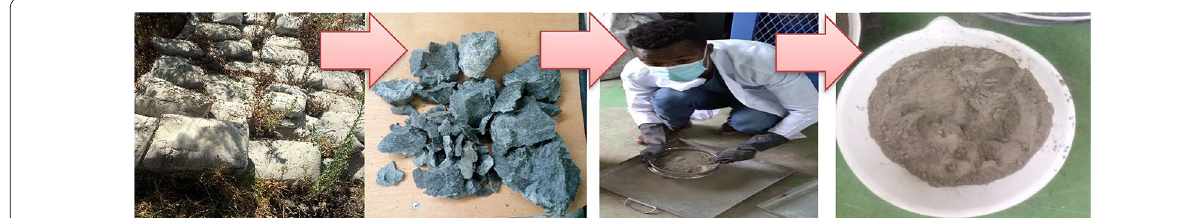
Fig. 3 EHC process from source to final preparation to mix